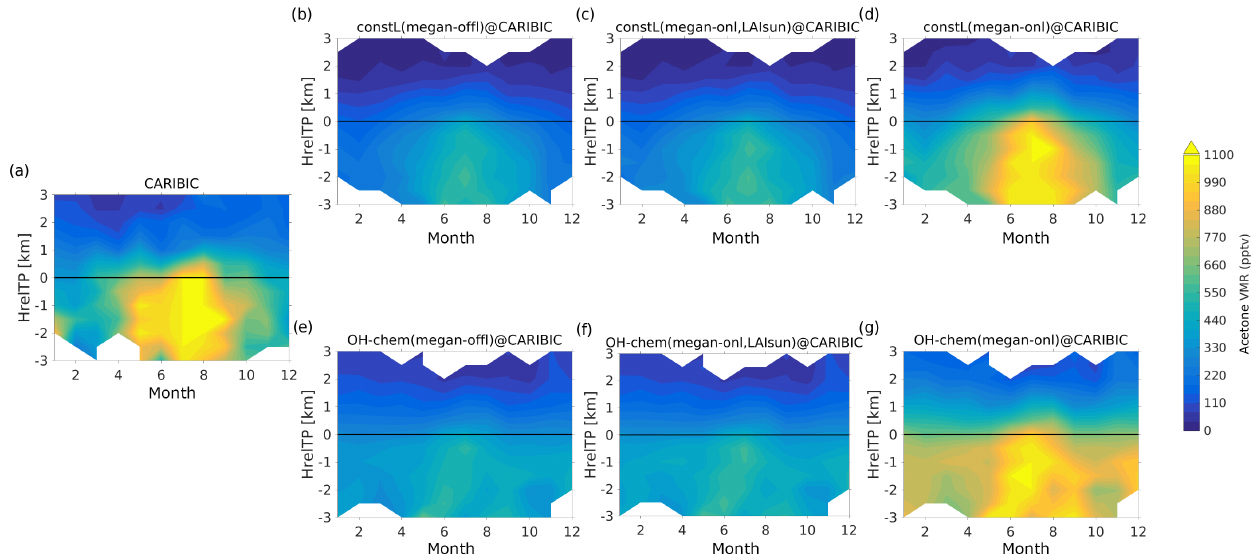
Figure 12. Annual cycles of the acetone VMR of (a) IAGOS-CARIBIC measurements and due to offline MEGAN-MACC (b, e) and MEGAN-Online biogenic emissions with LAI sun (c, f) and LAI (d, g) . Acetone VMR is shown ± 3km around the WMO tropopause for constL (first row) and OH-chem simulations (second row). Data are limited to the mid-latitudes between 35 to 75 ◦ N and to the pressure range between 180 and 280hPa. The acetone VMR in the IAGOS-CARIBIC measurements increases up to 1700pptv in the